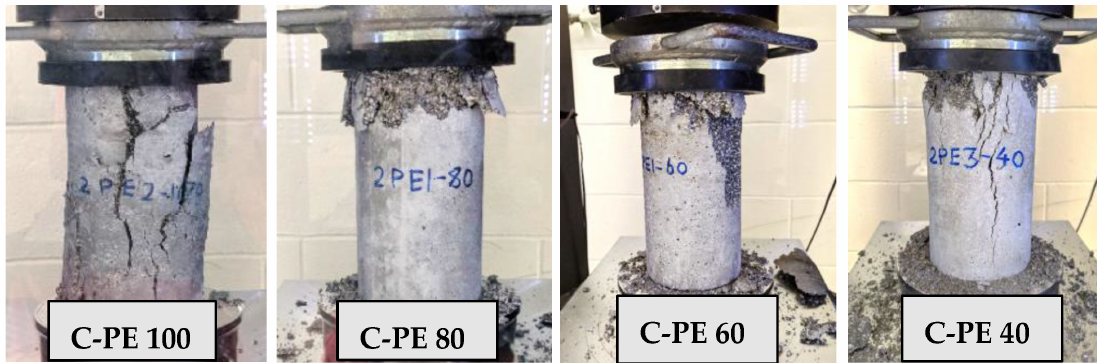
Figure 22. Compression failure patterns of C-PE cylinders.